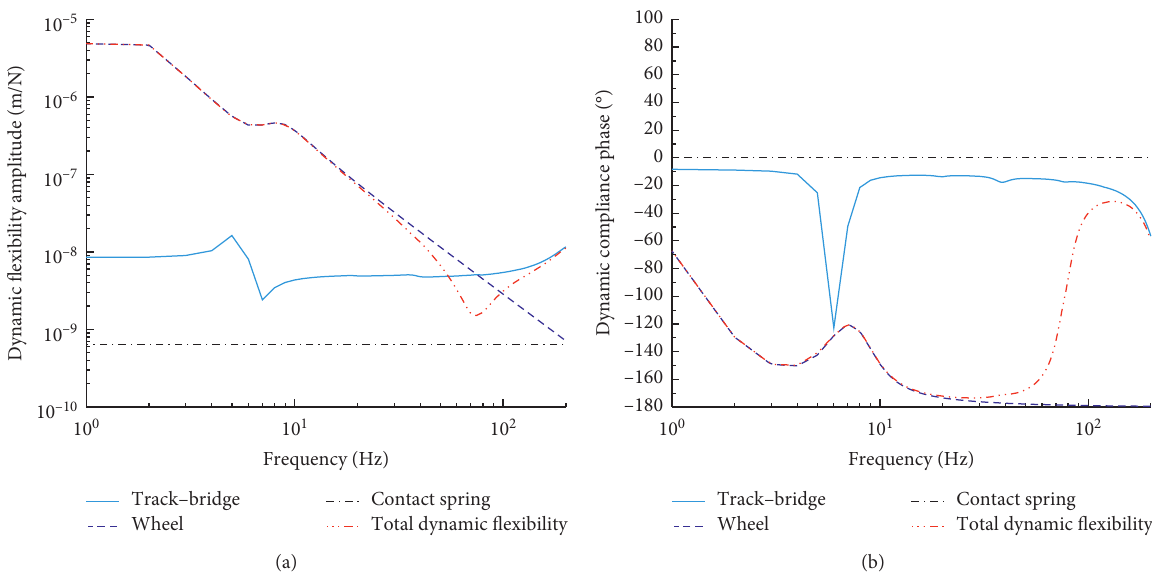
Figure 12: Dynamic compliance amplitude and phase of vehicle-track-bridge system with constant resistance elastic pad at − 20 ° C: (a) amplitude; (b)